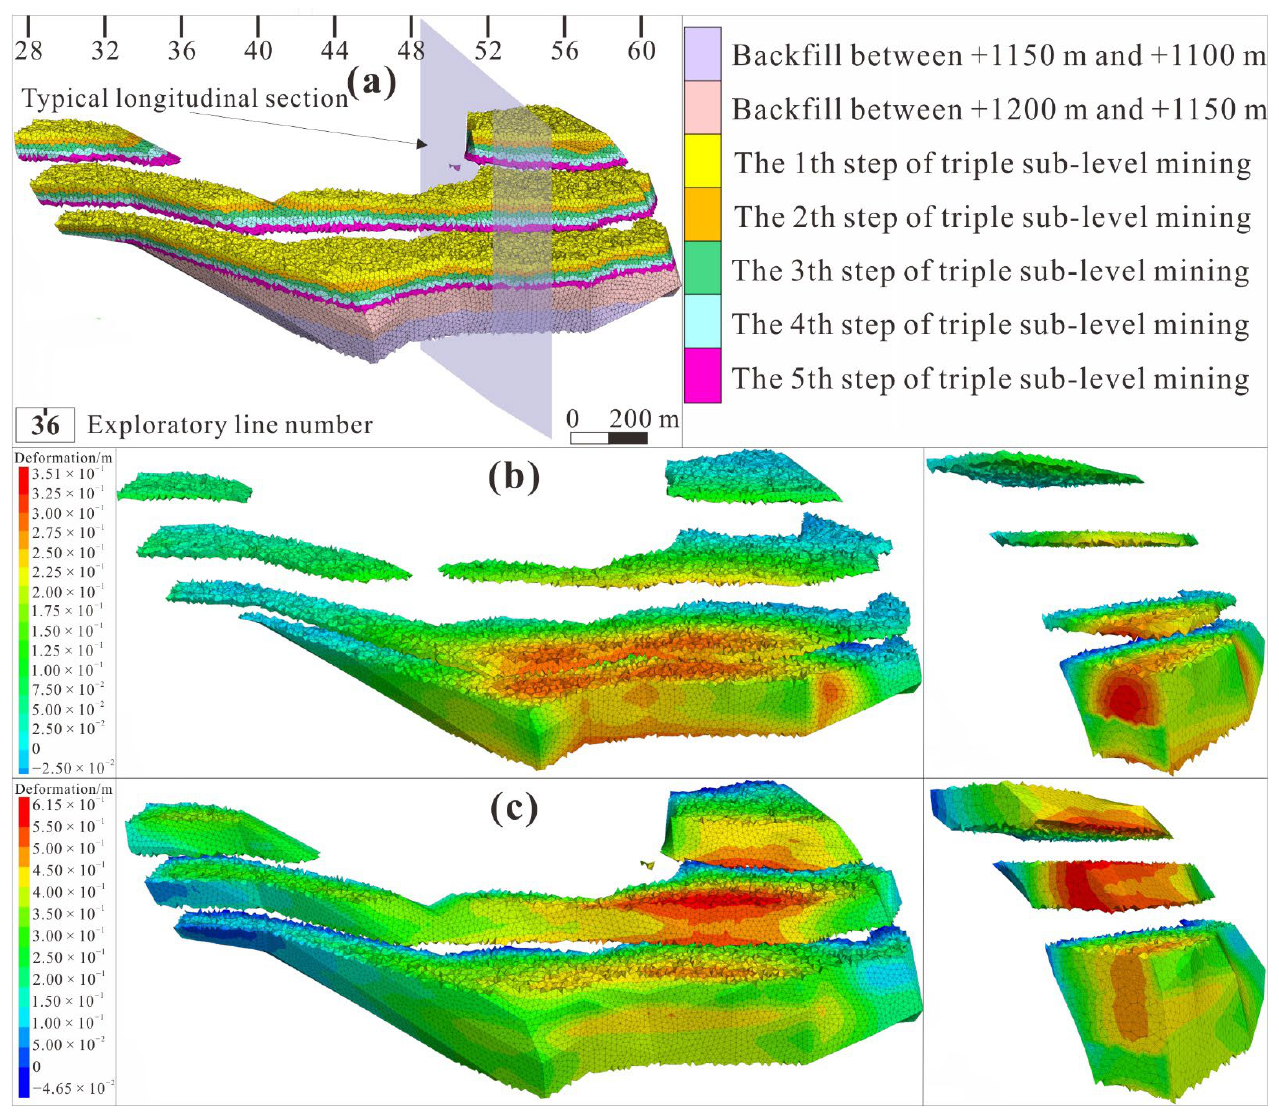
Figure 7. Numerical simulation results of backfill deformation. ( a ) Schematic diagram of filling body in each layer; ( b ) backfill deformation after the fourth mining step; ( c ) backfill deformation after the fifth mining step.